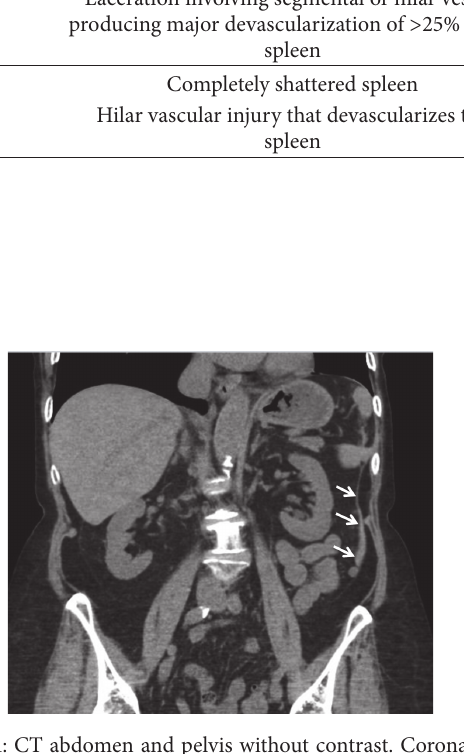
Figure 1: CT abdomen and pelvis without contrast. Coronal view showing small amount of high density perisplenic fluid (white arrows) tracking in the left paracolic gutter and extending into the